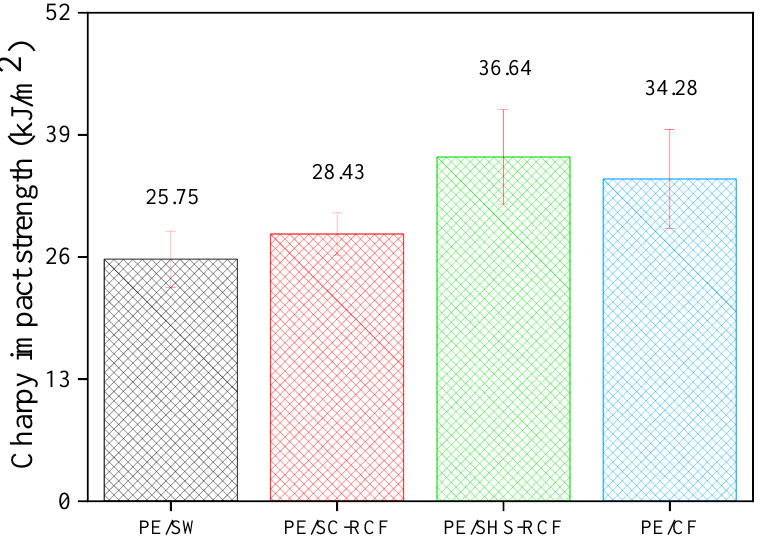
Figure 2. Charpy test results of the impact strength of RCF-reinforced low-density polyethylene (LDPE).